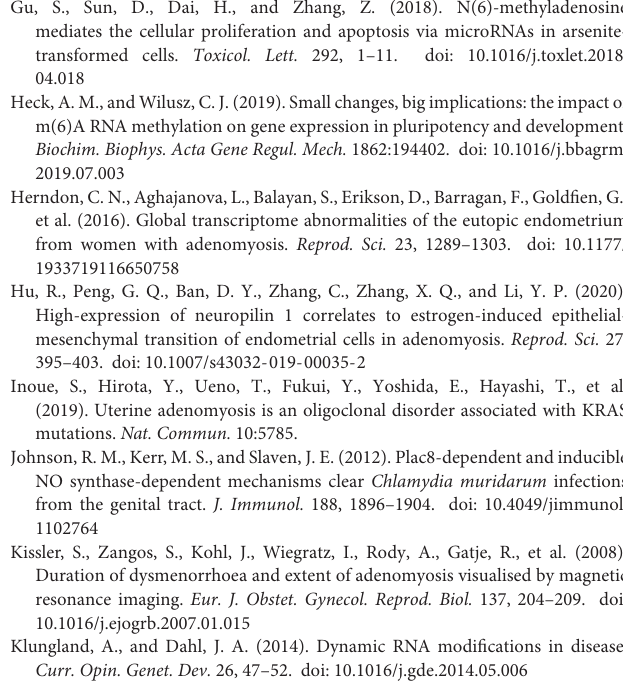
FIGURE S1 | m 6 A% content in the polyadenylated RNA of eutopic endometrium and myometrium of women with and without adenomyosis. (A) Eutopic endometrium; (B) Myometrium. n = 3 samples were analyzed in each group. FIGURE S2 | The IHC of METTL3 in the endometrium and myometrium of women with and without adenomyosis. (A) The endometrium of women with (right panel) and without adenomyosis (left panel). (B) the myometrium of women with (right panel) and without adenomyosis (left panel). Staining was assessed using Image J ( n = 3 for each group) and scored on a scale of 0 (negative) to 3 + (high positive). Scale bars is 50 µ m. The p -value was determined by a χ 2 -test. FIGURE S3 | The WGCNA of DEGs in the myometrium of women with and without adenomyosis. Red arrow revealed the module that the differential expressed m 6 A RNA methylation regulators belongs